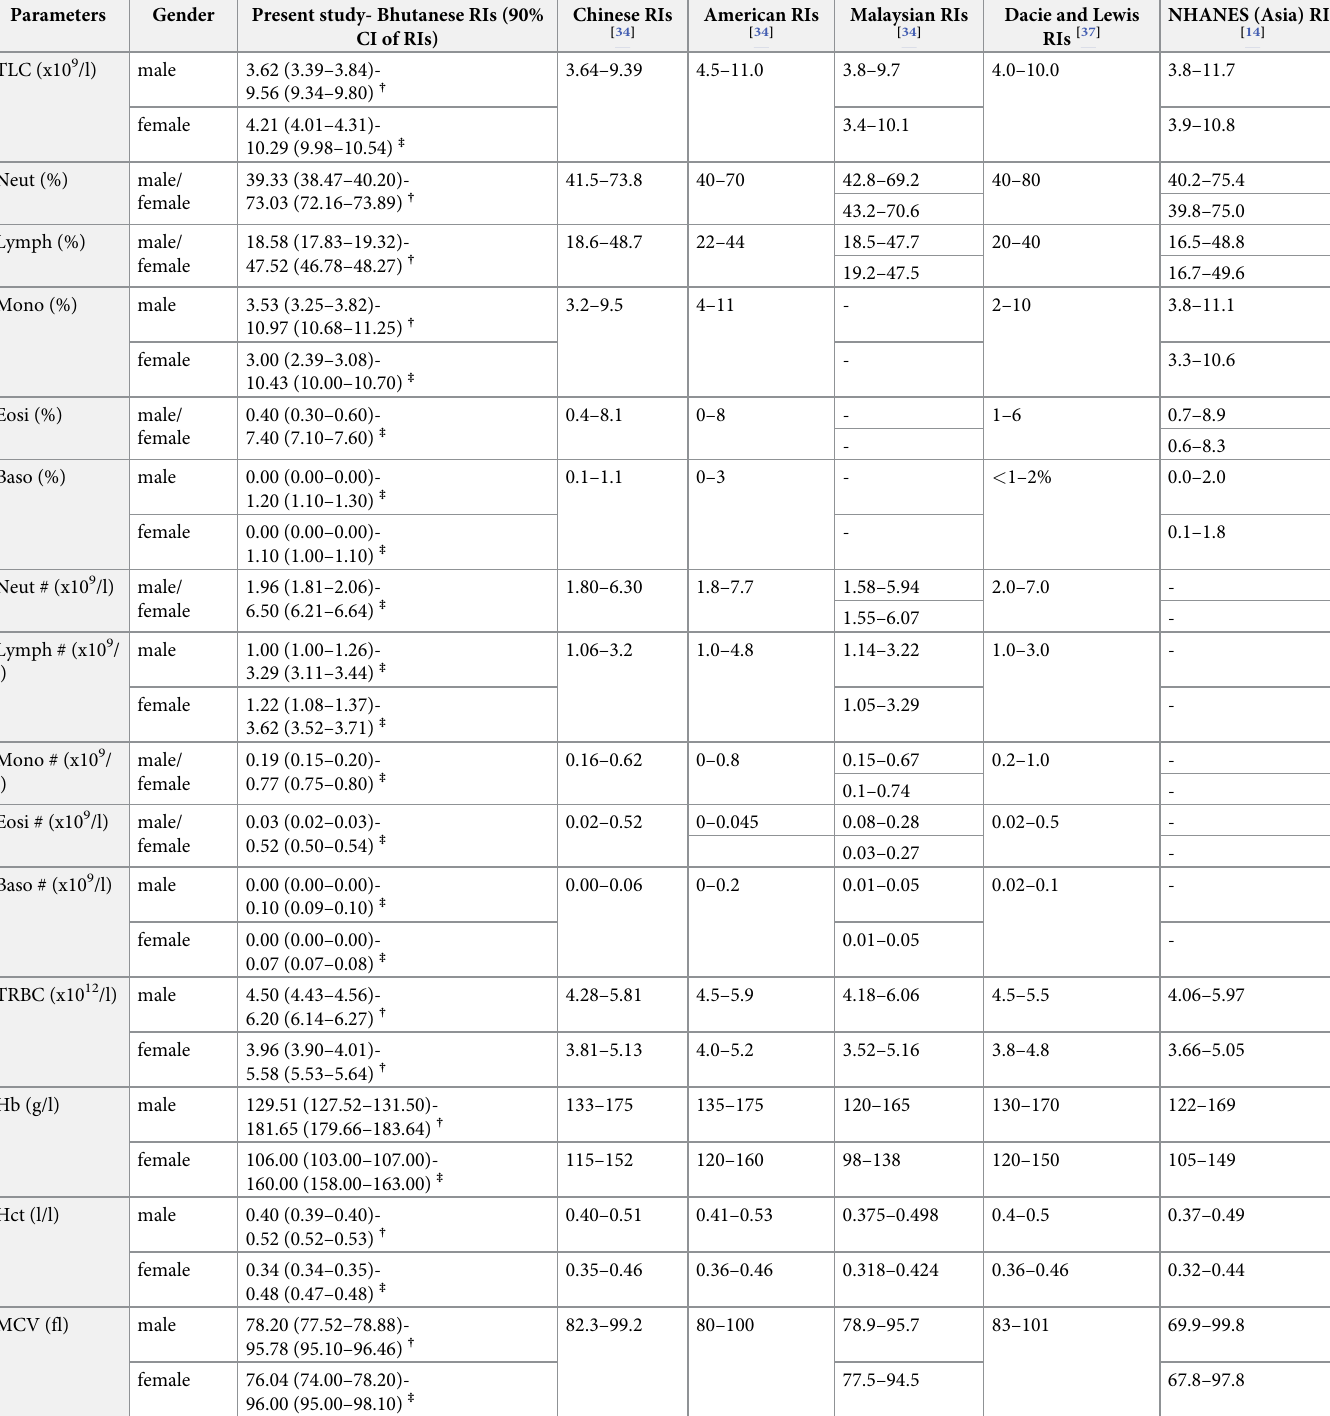
Table 7. The haematology RIs of healthy Bhutanese adults, 90% CI of the reference limits and other published haematology RIs for comparison.